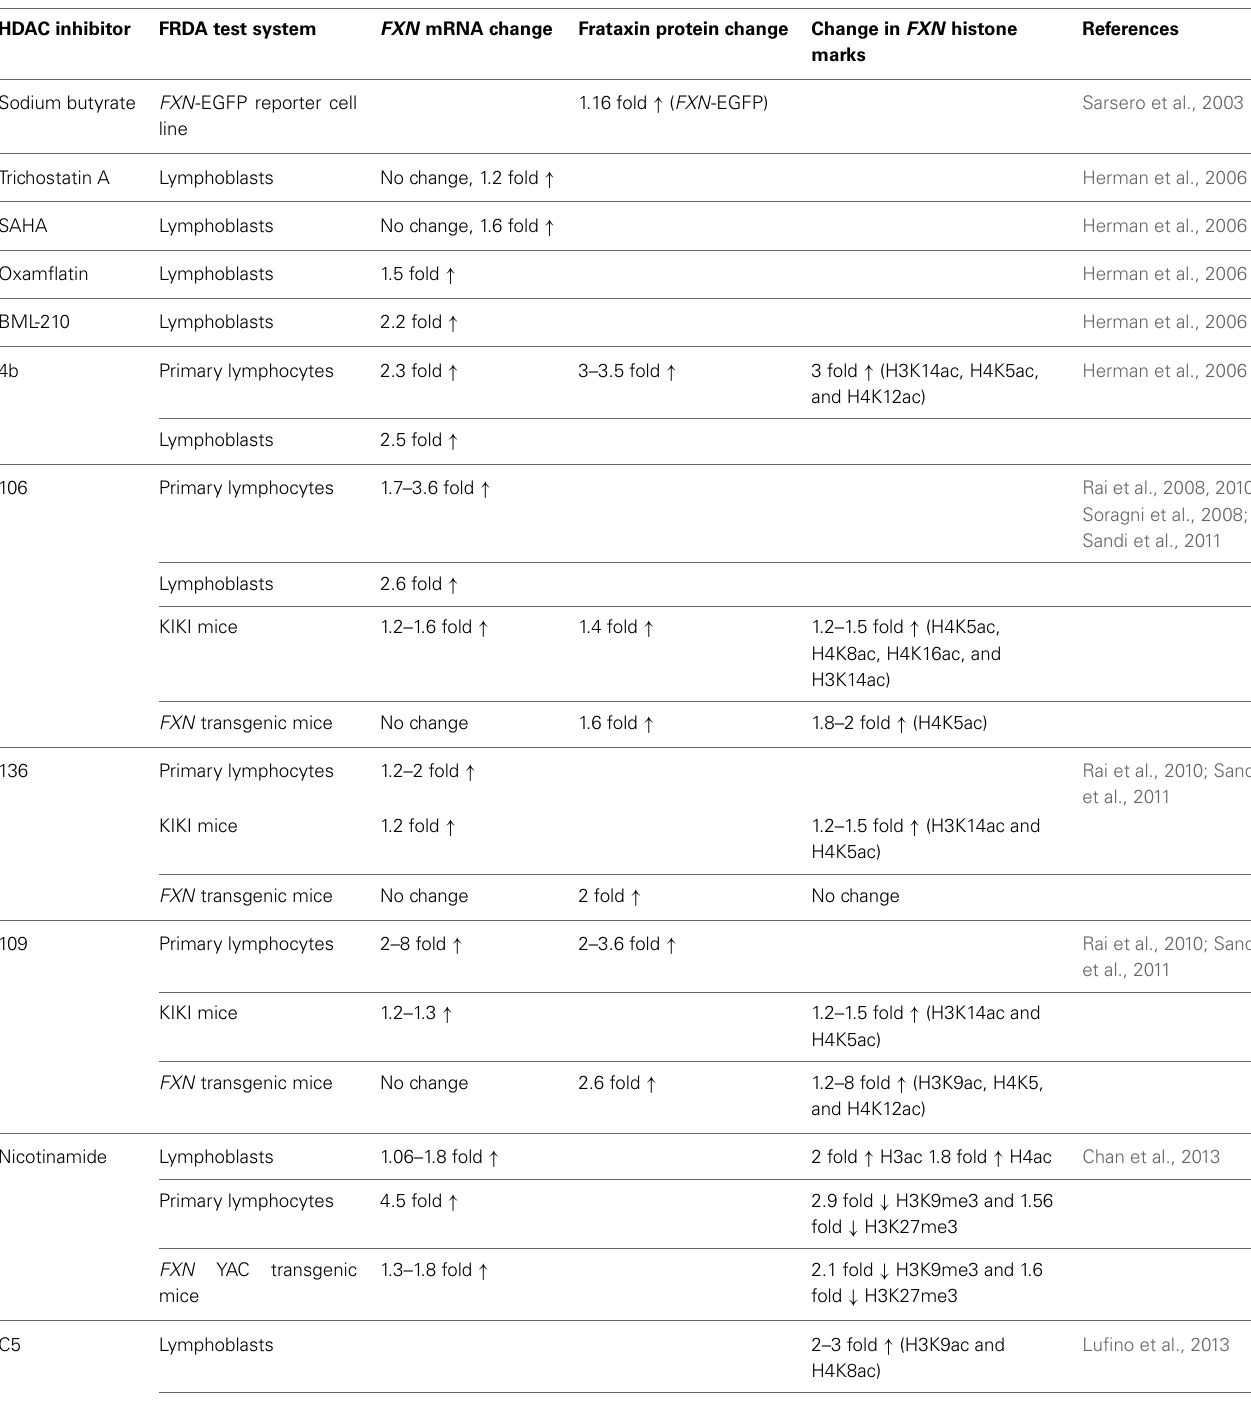
Table 2 | HDAC inhibitor preclinical studies of FRDA cells and